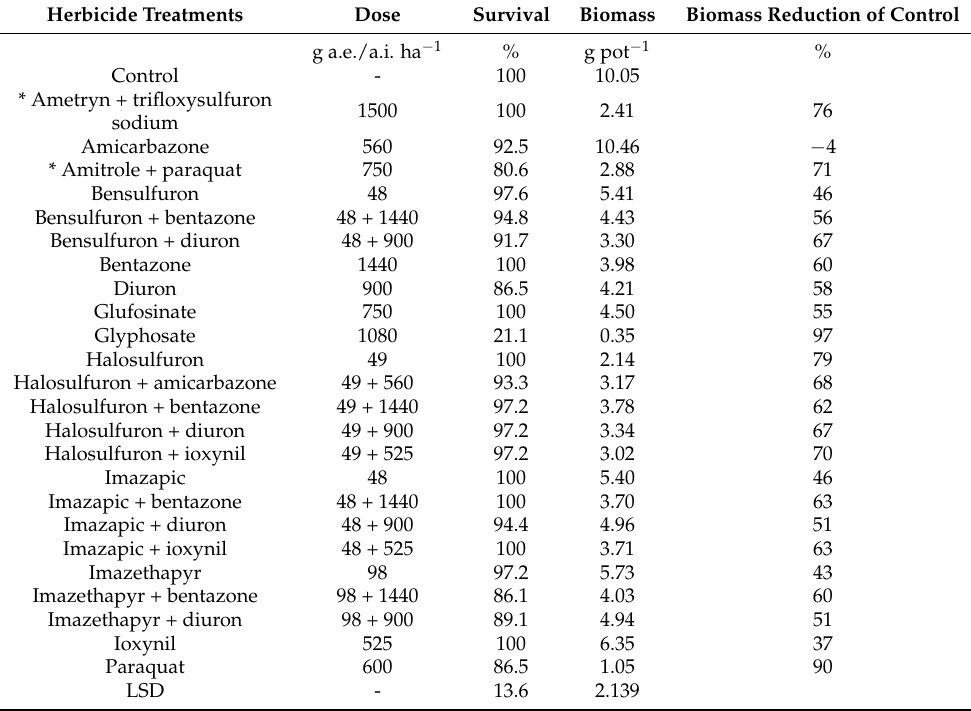
Table 3. The effect of herbicide treatments on the survival and biomass of Navua sedge when sprayed on 8–10 cm tall plants (10–12 leaf